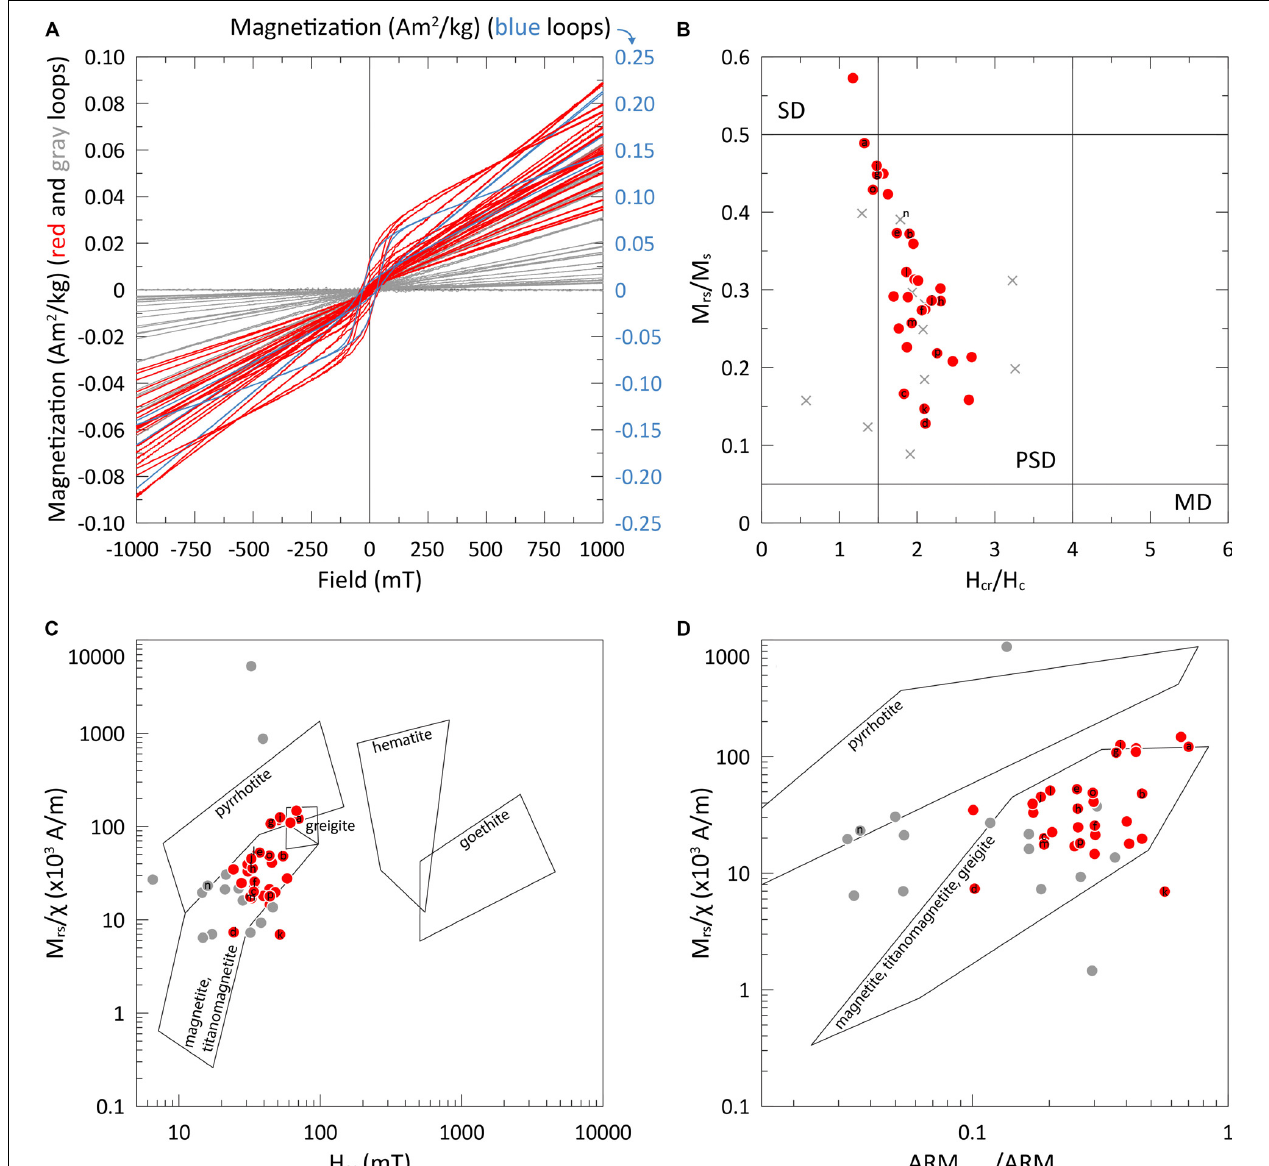
FIGURE 4 | (A) Uncorrected hysteresis loops of discrete samples from the Lake Junín Splice. Red loops and blue loops (slope corrected M s > 1.5 × 10 - 3 Am 2 /kg) have an identifiable ferrimagnetic component in addition to paramagnetic behavior, gray loops (slope corrected M s < 1.5 × 10 - 3 Am 2 /kg) have weaker magnetizations and are dominated by paramagnetic behavior. The four blue loop samples have M s values > 0.1 Am 2 /kg and are plotted on a separate y -axis with a different color for clarity purposes only. (B) Discrete samples following paramagnetic correction plotted within Day Plot space [ H cr / H c 0–6; M rs / M s 0–0.6; (Day et al., 1977)]; magnetically weaker gray loop data are denoted as crosses. (C) H cr vs. M rs / χ biplot and (D) ARM intensity following 40 mT AF demagnetization normalized by the acquired ARM intensity prior to AF demagnetization (ARM 40 mT /ARM 0 mT ) vs. M rs / χ biplot. Data in (C,D) are compared to measured data from